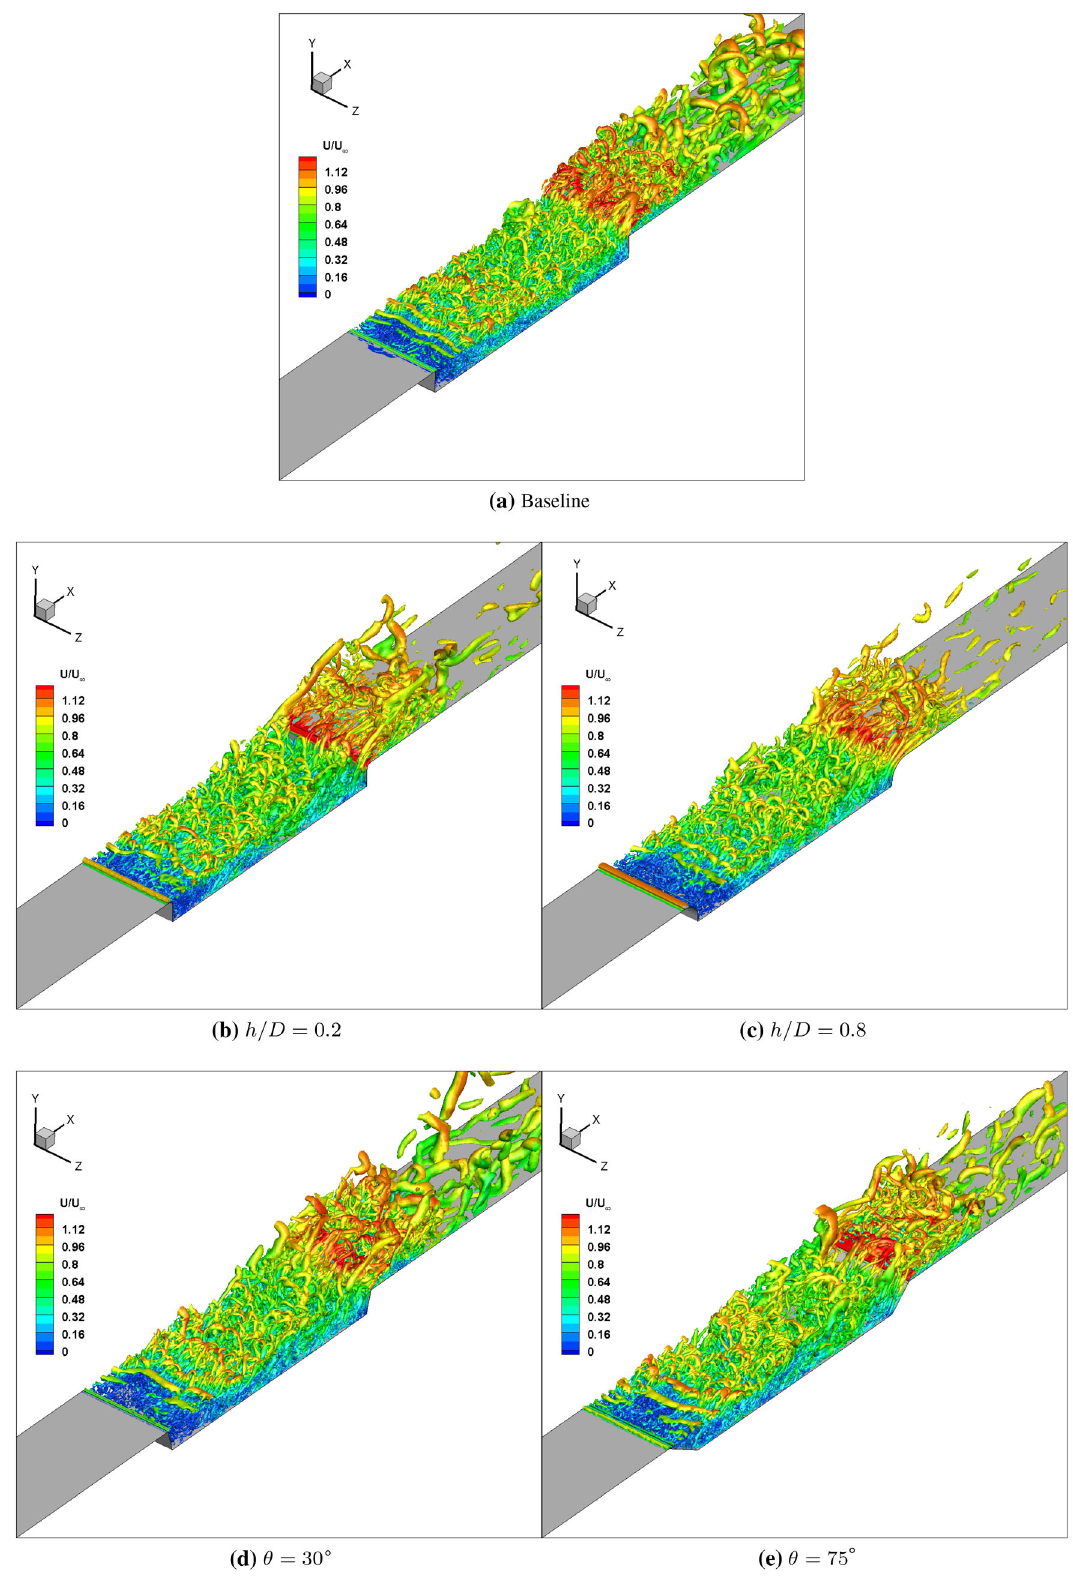
Fig. 7 Flow structure demonstrated by iso-surface of Q -criterion Q norm ¼ 2 :